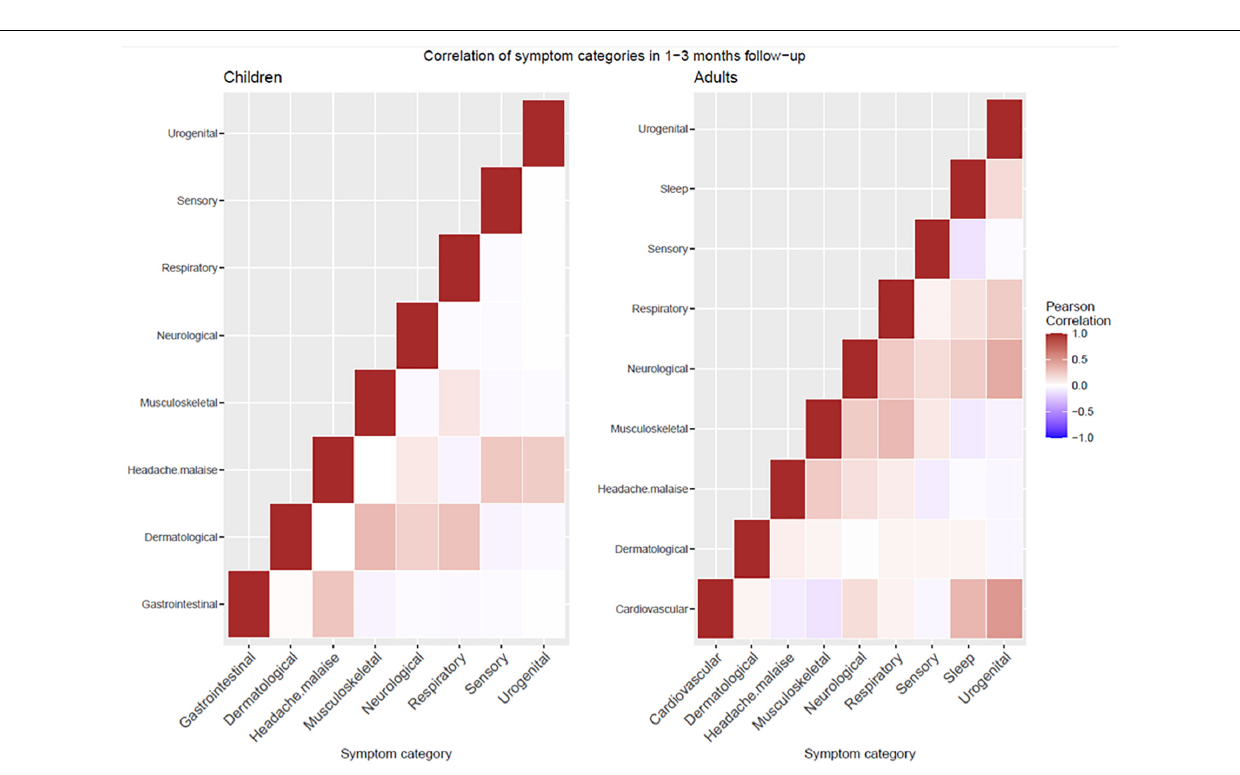
FIGURE 2 | Correlation of symptoms heatmaps in children (left) and adults (right)